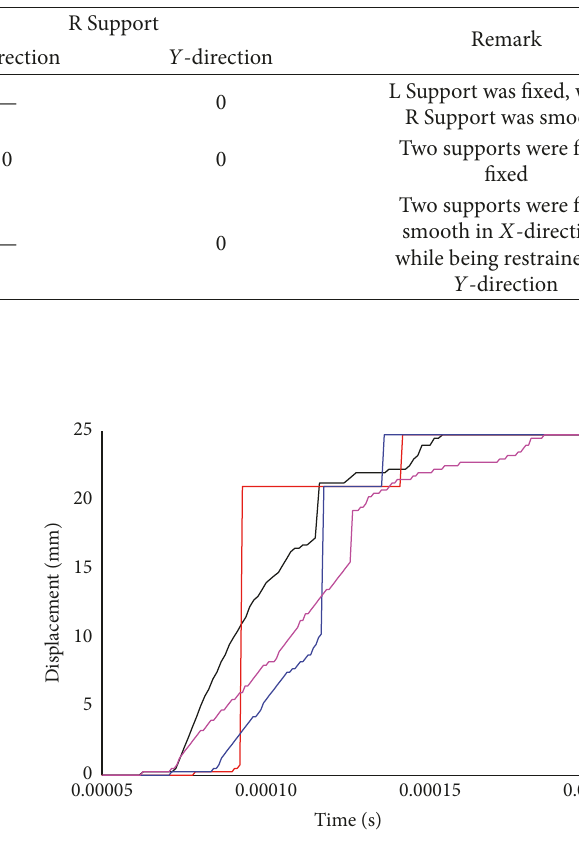
Table 3: Support restraints.